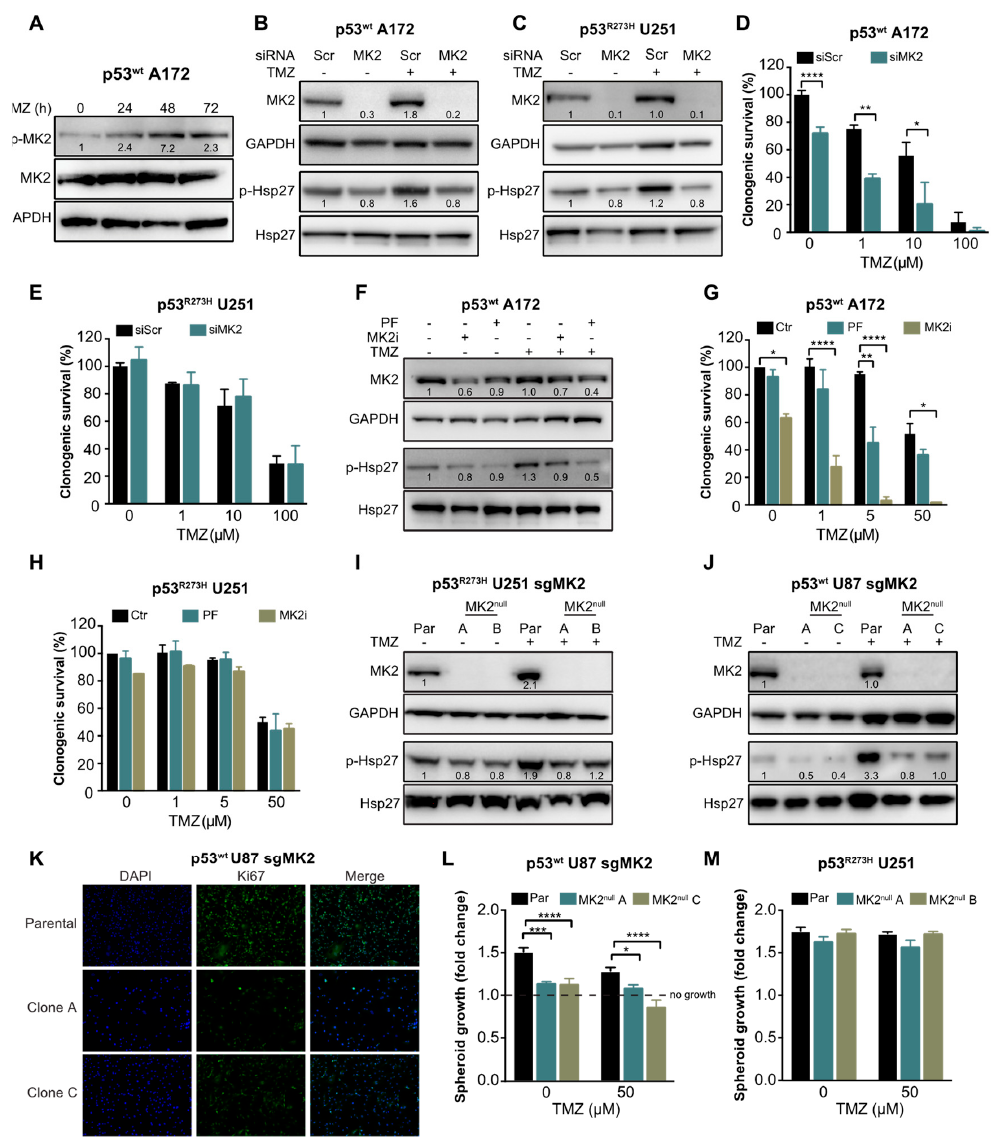
Figure 2. MK2 inhibition attenuates proliferation of p53 wt glioblastoma cells. ( A ) Cells were treated with temozolomide (50 μ M) for 0–72 hr and lysates immunoblotted against indicated antibodies. ( B,C ) Scramble (Scr) or MK2 siRNA transfected cells were treated with temozolomide (TMZ, 50 μ M, 48 hr) and lysates immunoblotted against indicated antibodies. ( D,E ) Scramble or MK2 siRNA transfected cells were treated with temozolomide and colonies quantified after 12 days of treatment. ( F ) Cells were treated with PF-3644022 (PF, 3 μ M), MK2 inhibitor IV (MK2i, 1.5 μ M) and temozolomide (50 μ M, 48 hr) and lysates immunoblotted against indicated antibodies. ( G,H ) Cells were treated with PF-3644022 (3 μ M), MK2i (1.5 μ M) and temozolomide and colonies quantified after 12 days of treatment. ( I,J ) Parental (Par) and MK2 null cells were treated with temozolomide (50 μ M, 48 hr) and lysates immunoblotted against indicated antibodies. ( K ) Parental and MK2 null cells were stained with Ki67 antibody and DAPI. ( L,M ) Parental and MK2 null spheroids were treated with temozolomide and growth calculated as the spheroid size on Day 16 over Day 2 (treatment day). All immunoblot images and band intensities are representatives of 3-4 independent experiments. Bar graphs for clonogenic and spheroid growth assays represent mean ± SEM from 3 independent experiments performed in duplicate (* p < 0.05; ** p < 0.01; *** p < 0.001; **** p < 0.0001; one-way ANOVA followed by Bonferroni’s post-test for multiple comparison). Immunofluorescence images are representatives of 3 independent experiments.